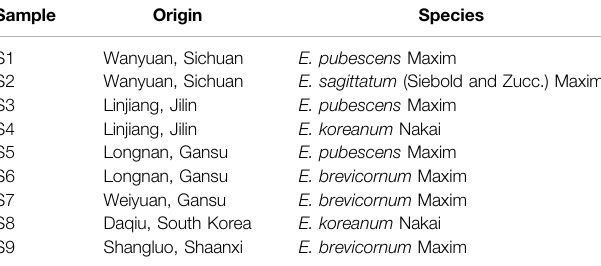
TABLE 1 | Sources and species of Epimedii Folium